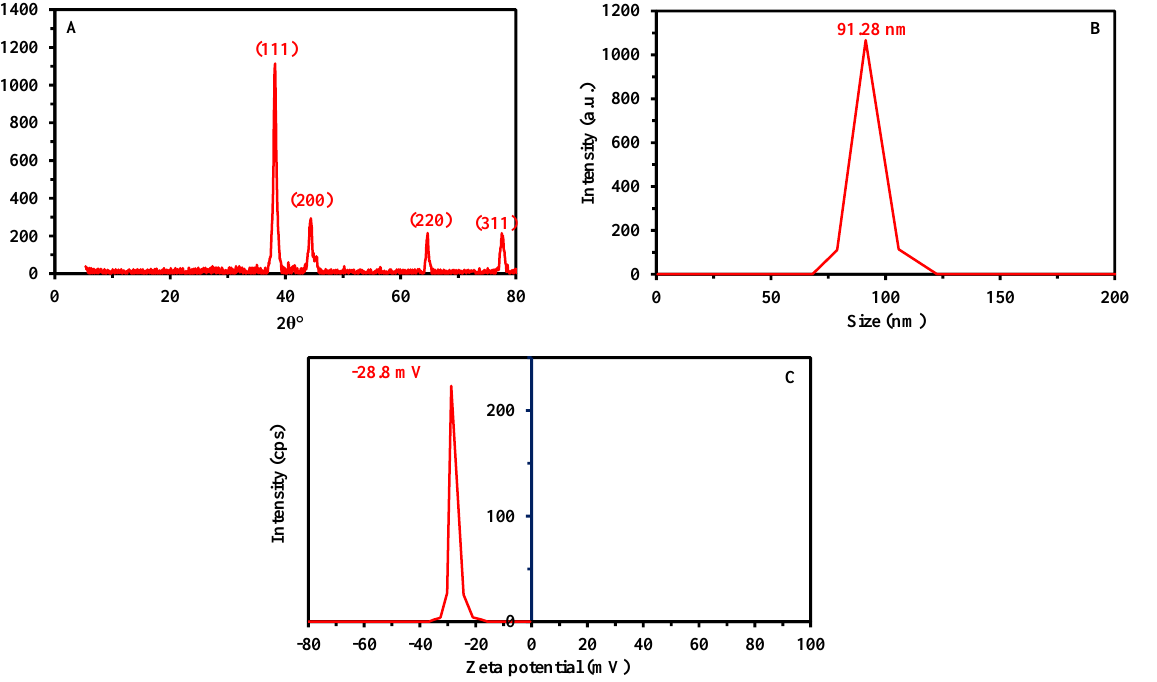
Figure 3. Characterization of AuNPs. ( A ) XRD analysis; ( B ) DLS measurements; ( C ) zeta potential analysis.